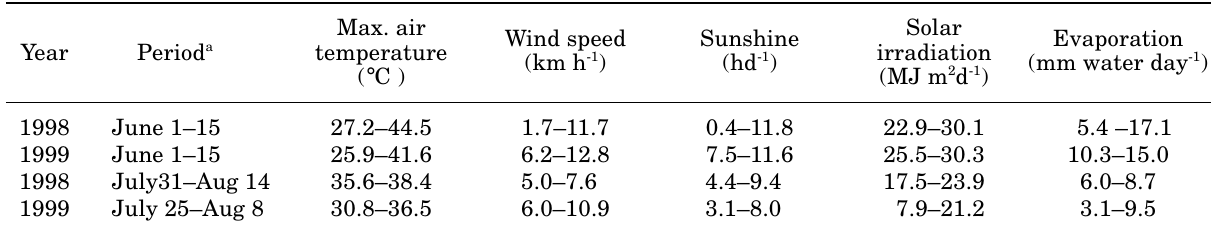
Table 1. Maximum air temperature range and related weather data recorded during the test period. Max.